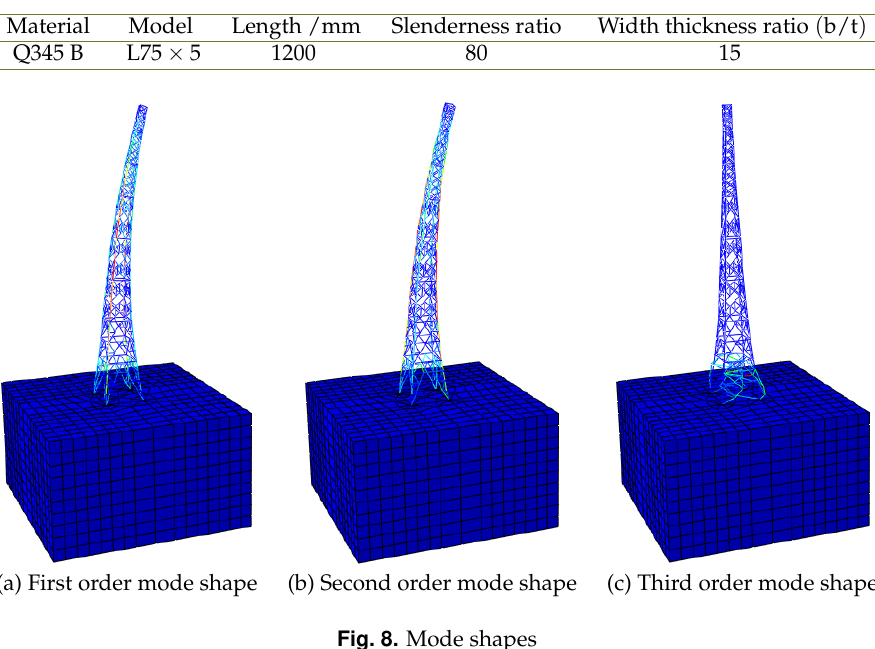
Table 8. Specimen size